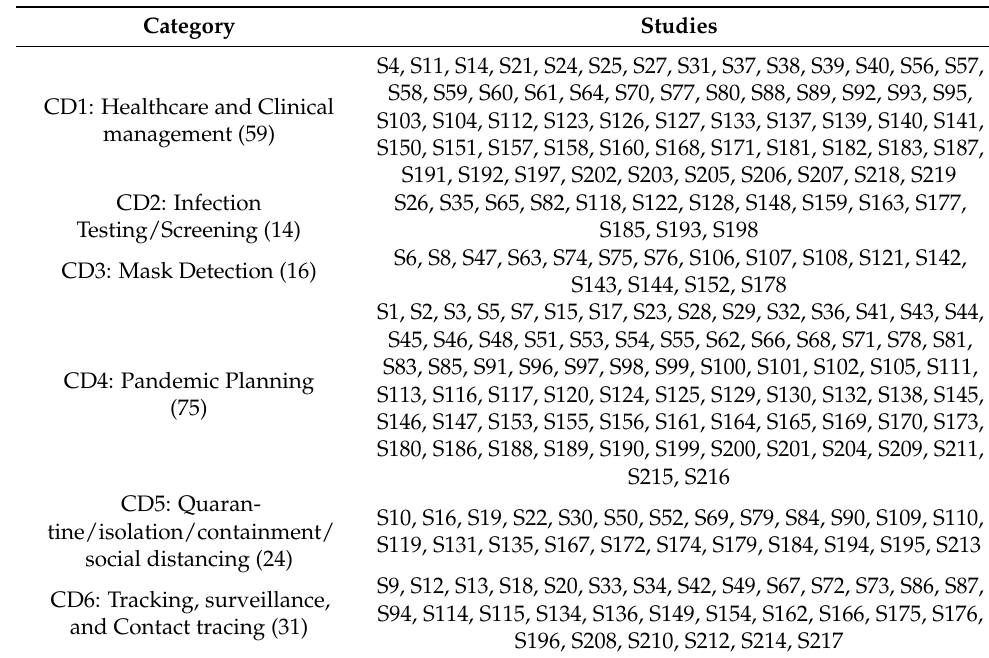
Table 7. Application Domain